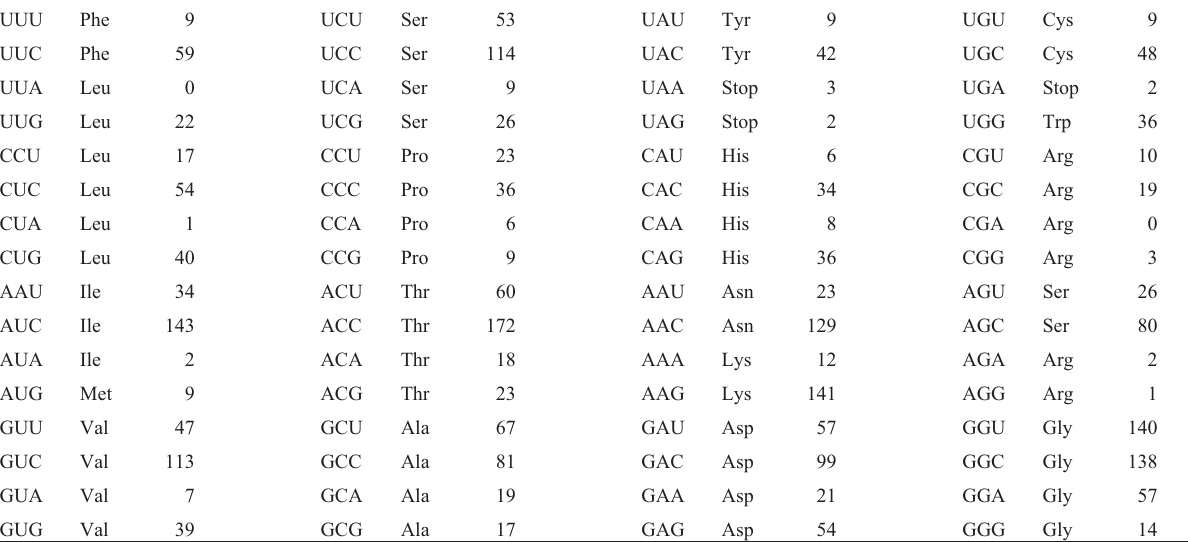
Table I - Codon utilization in polygalacturonase-encoding genes from Penicillium